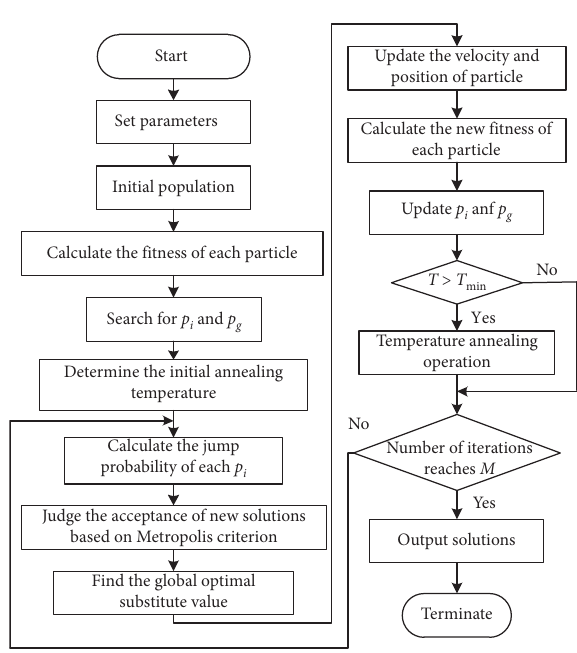
Figure 4: Flowchart of SAPSO